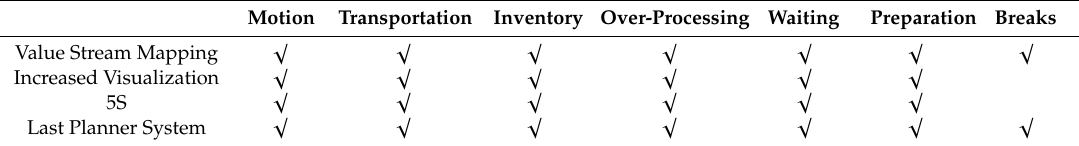
Table 6. Observed waste types that can be improved with 4 Lean